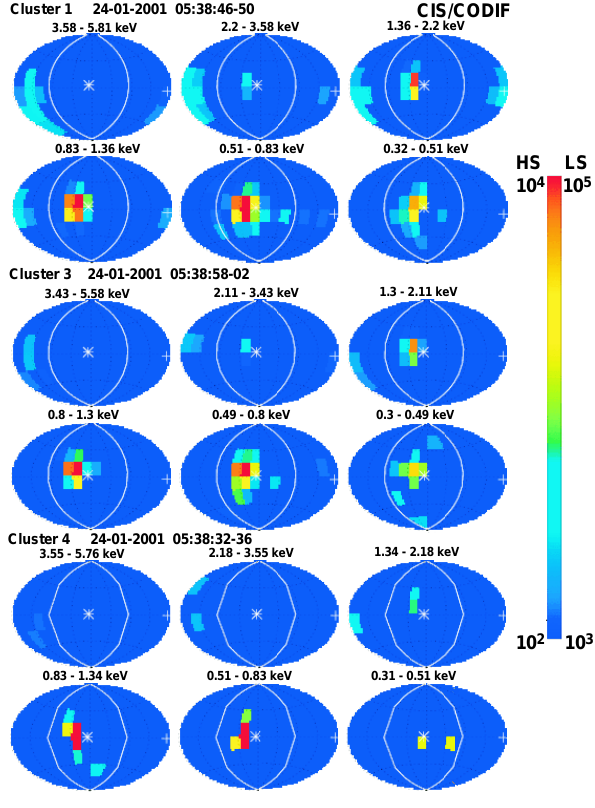
Fig. 3a. 4 π angular distributions of the H + fluxes from CODIF in color-coded representation for 6 energies from spacecraft 1 (top), spacecraft 3 (center), and spacecraft 4 (bottom) ≈ 1min before bow shock entry. Shown is the instrument view of the incoming particle flux. The white star indicates the magnetic field pointing out of the figure and the cross indicates the magnetic field pointing into the figure. The white line indicates a 90 ◦ pitch angle. The scaling of the color bar (in differential flux) is higher by a factor of 10 for the low sensitivity (LS) mode of CODIF on spacecraft 4, because in high sensitivity (HS) mode, the sensor saturates at the lower maximum flux levels chosen for spacecraft 1 and